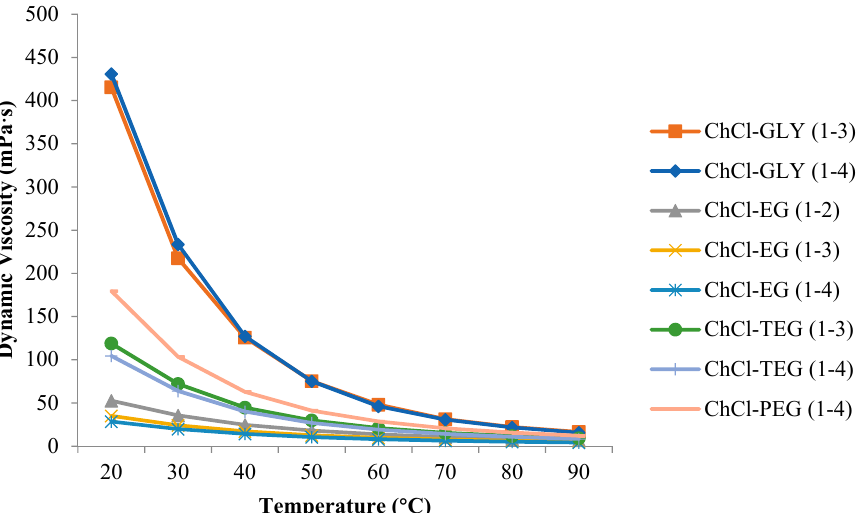
Figure 3. Changes in DES density with increasing temperature.